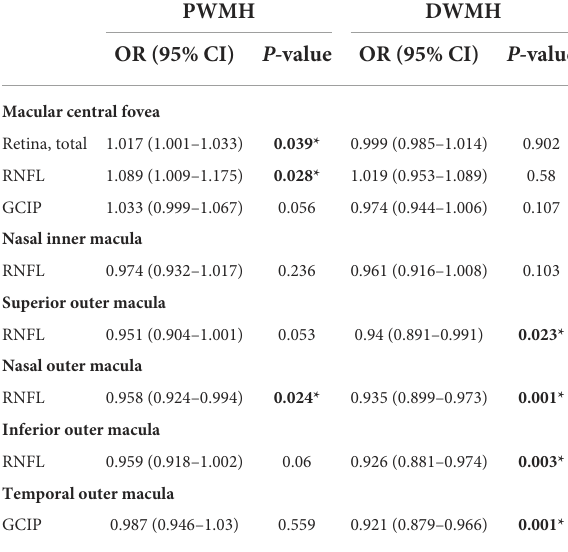
TABLE 6 Logistic regression analysis of retinal thickness in different subfield-related factors for moderate-severe periventricular and deep white matter hyperintensity.